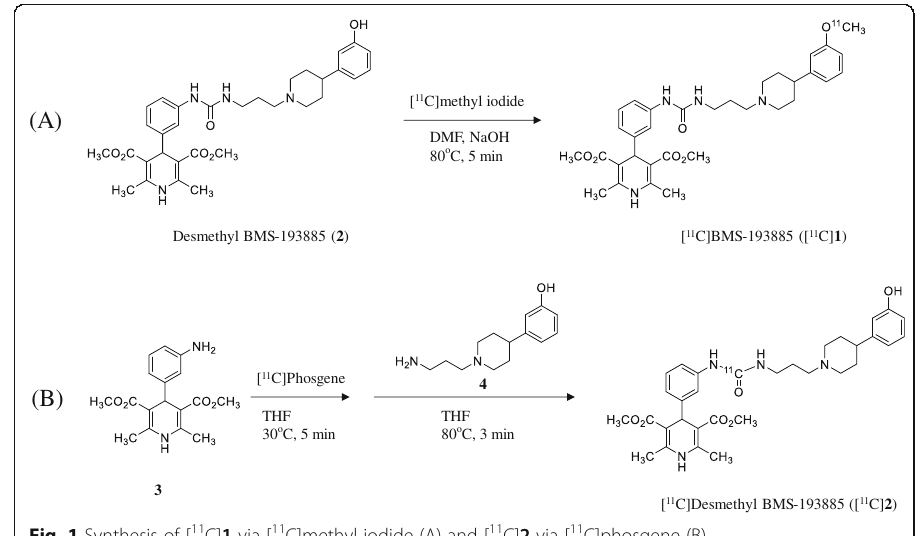
Fig. 1 Synthesis of [ 11 C] 1 via [ 11 C]methyl iodide (A) and [ 11 C] 2 via [ 11 C]phosgene